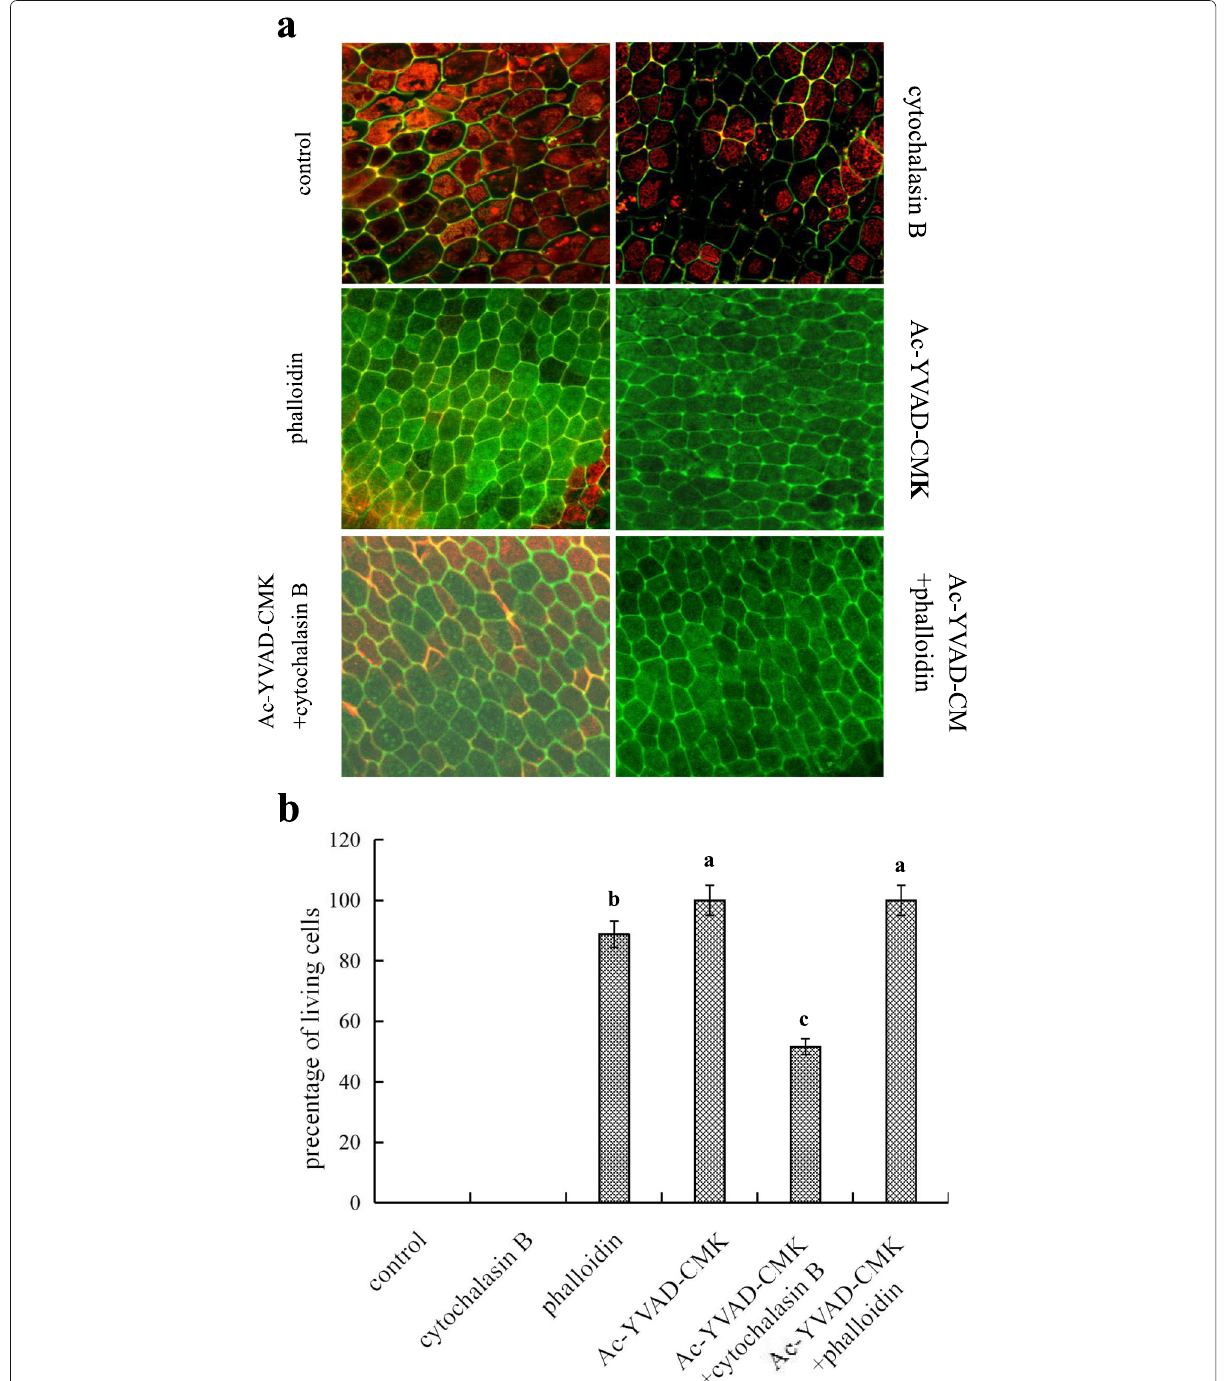
Fig. 7 The inhibition of OsVPE3 delayed the process of PCD in rice aleurone layers. Aleurone layers were stripped from the intact seeds imbibed for 12 h, and then the isolated layers were pre-incubated in a solution containing distilled water alone (control) or 10 μ g/mL phalloidin (AF depolymerization inhibitor), 10 μ g/mL cytochalasin B (CB) (AF depolymerizer), 10 μ M Ac-YVAD-CMK (caspase-1 inhibitor) alone or in combination for 7 d. Finally, the stained layers with FM-4-64 (orange or red, dead cells) and FDA (green, live cells) were observed to distinguish live cells and dead cells under LSCM, and the corresponding images were immediately captured. a The captured images were performed three times and a representative aleurone layer section is shown. Scale bar is 10 μ m. b The survival rate of cells was quantified for at least three aleurone layers. Error bars indicate the means ± s.d., n = 3 biological independent experiments with at least three replicates for each. Bars with different alphabets show significant different at P < 0.05 according to Duncan’s multiple range